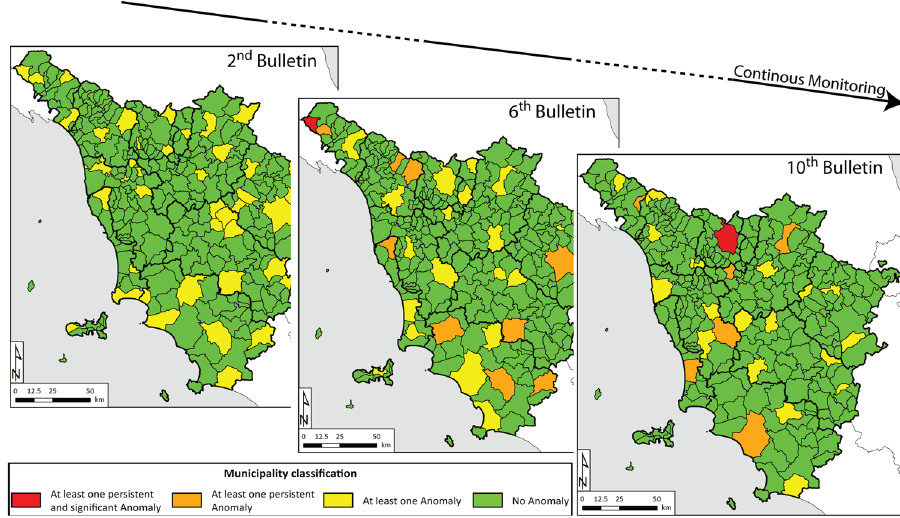
Figure 3. Monitoring bulletins released every 12 days to the Tuscany Region authorities. The presence of a cluster of persistent anomalies affecting elements at risk determines a significant level of risk, with the necessity of field survey and further analysis. Maps were generated using ESRI ArcGIS 10.3 platform (https://www.esri.